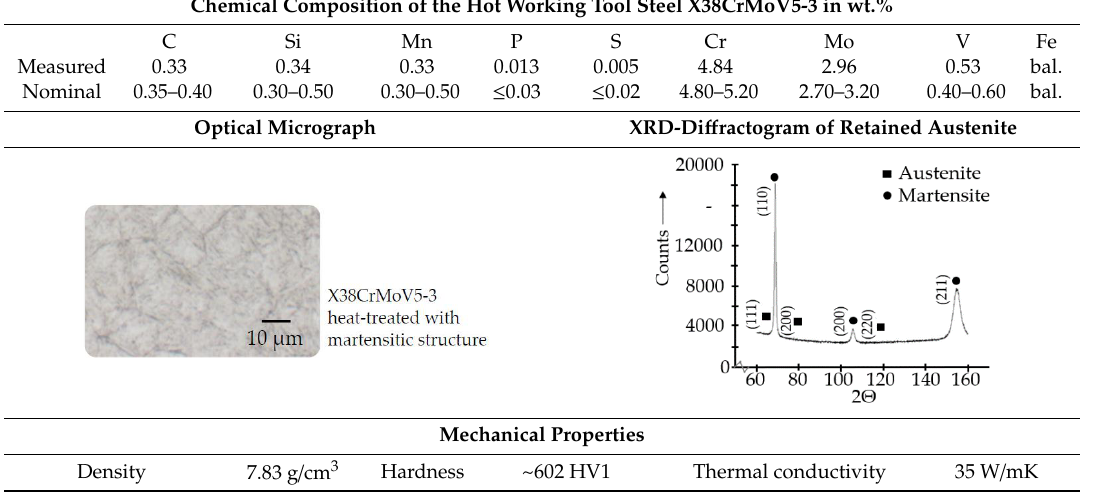
Table 2. Mechanical properties of the applied hard ceramic particles.